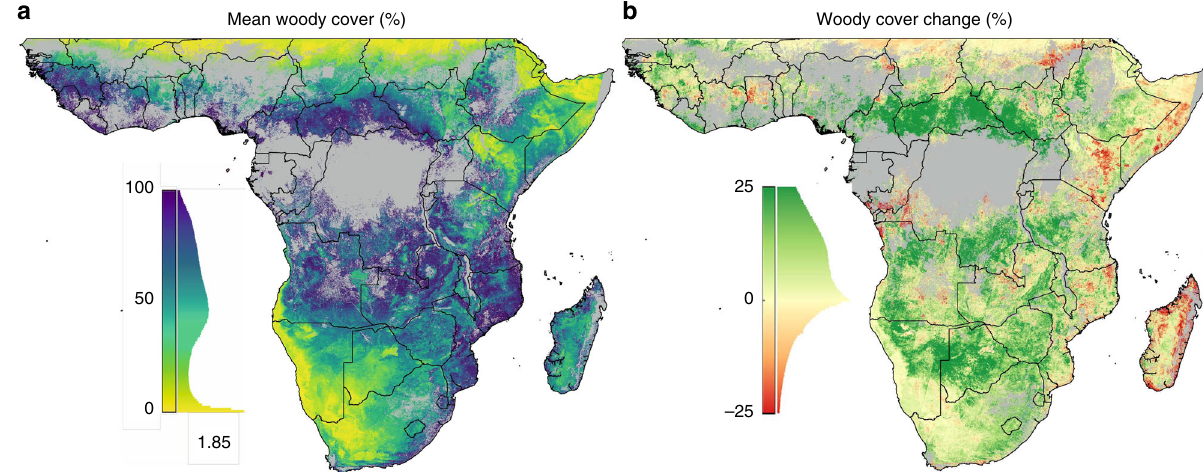
Fig. 1 Woody plant cover dynamics over sub-Saharan Africa. Satellite observations of 30 years of fractional woody plant cover ( a ) reveal a dominant increasing trend (derived from the slope of the linear trend line between 1986 and 2016) ( b ). Histograms alongside colour scales indicate data distributions. Grey areas were masked from the analysis and represent urban surfaces, wetland, cropland, and forest (areas >40% cover by trees >5 m). Maps were constructed in Google Earth Engine